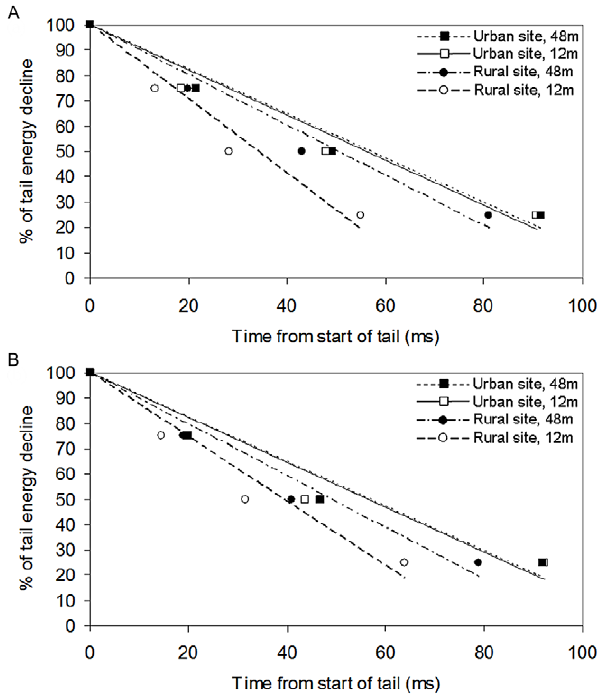
Figure 6. The rate of tail energy decline (RTD) for great tit songs after transmission. RTD over 12 m & 48 m, indicated by regression lines through time points 0, Q1, Q2 and Q3 (energy remaining: 100%, 75%, 50% and 25% respectively) for rural songs used in (a) experiment 1 and (b) experiment 2.